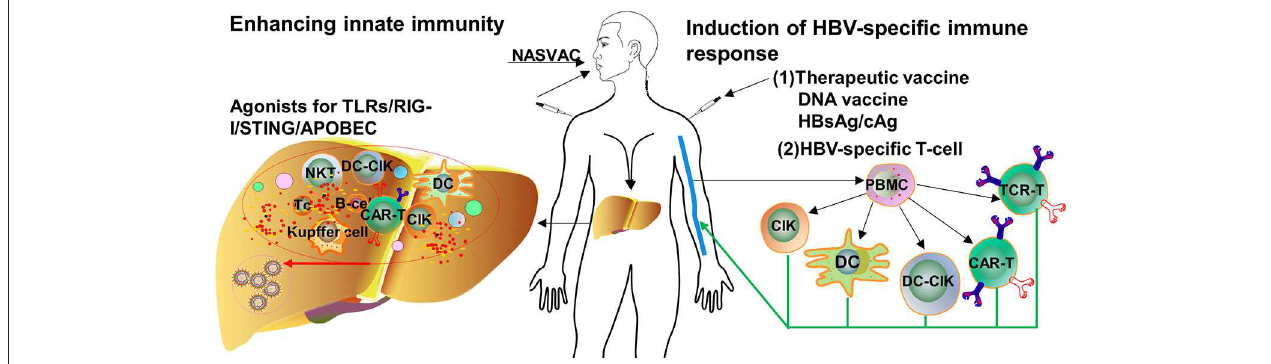
FIGURE 1 | Approaches for the treatment of chronic HBV infection. Available knowledge about HBV immune control and immunopathogenesis; a number of immunomodulatory strategies have been tested to enhance innate and adaptive immunity in preclinical models and clinical trials. TLR, toll-like receptor; RIG-I, retinoic acid-inducible gene 1; STING, stimulator of interferon genes; APOBEC, apolipoprotein B mRNA-editing enzyme catalytic subunit; PBMC, peripheral blood mononuclear cell; DC, dendritic cell; CIK, cytokine-induced killer; CAR-T, chimeric antigen receptor T-cell; TCR, T cell receptor. Dots in various colors indicate different cytokines.